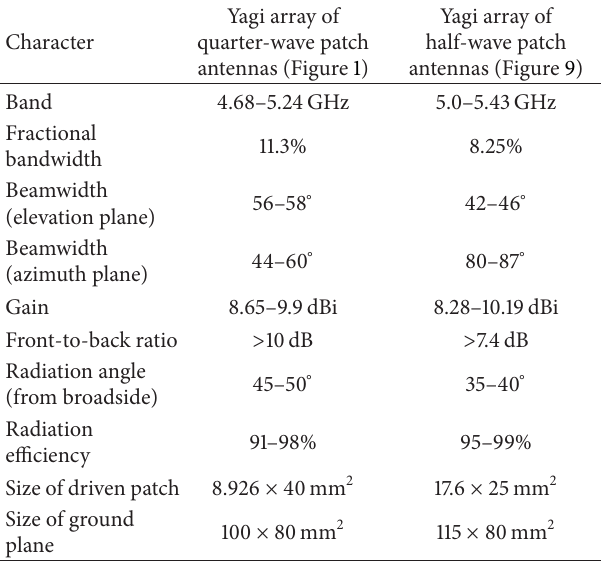
Table 2: Comparisons between the Yagi array of quarter-wave patch Antennas and the Yagi array of half-wave patch